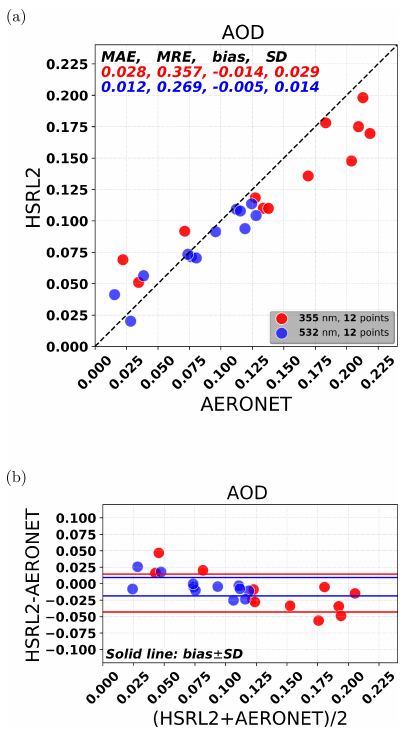
Figure 4. Comparison between HSRL-2 and AERONET for AOD at 355 and 532nm. (a, b) The scatter plot and the difference plot,